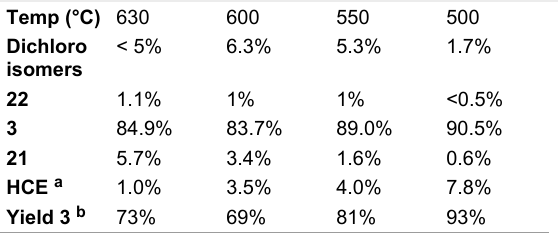
Table 1: Vapor Phase Chlorination of 2-Thiophenecarbonitrile 20 : Product Composition as a Function of Reactor Temperature (GC